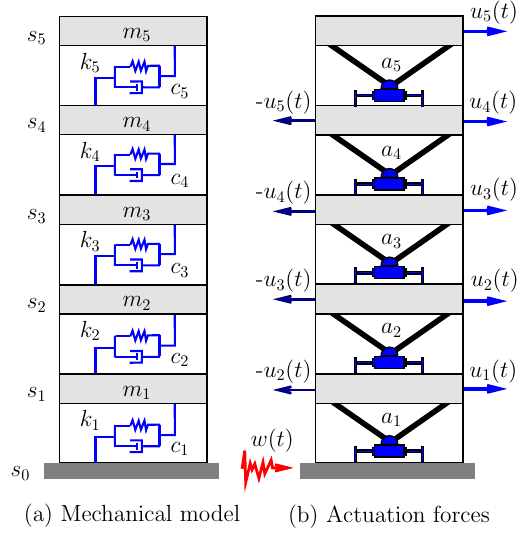
Figure 4: Five story-building mechanical model, actu- ation forces, and external